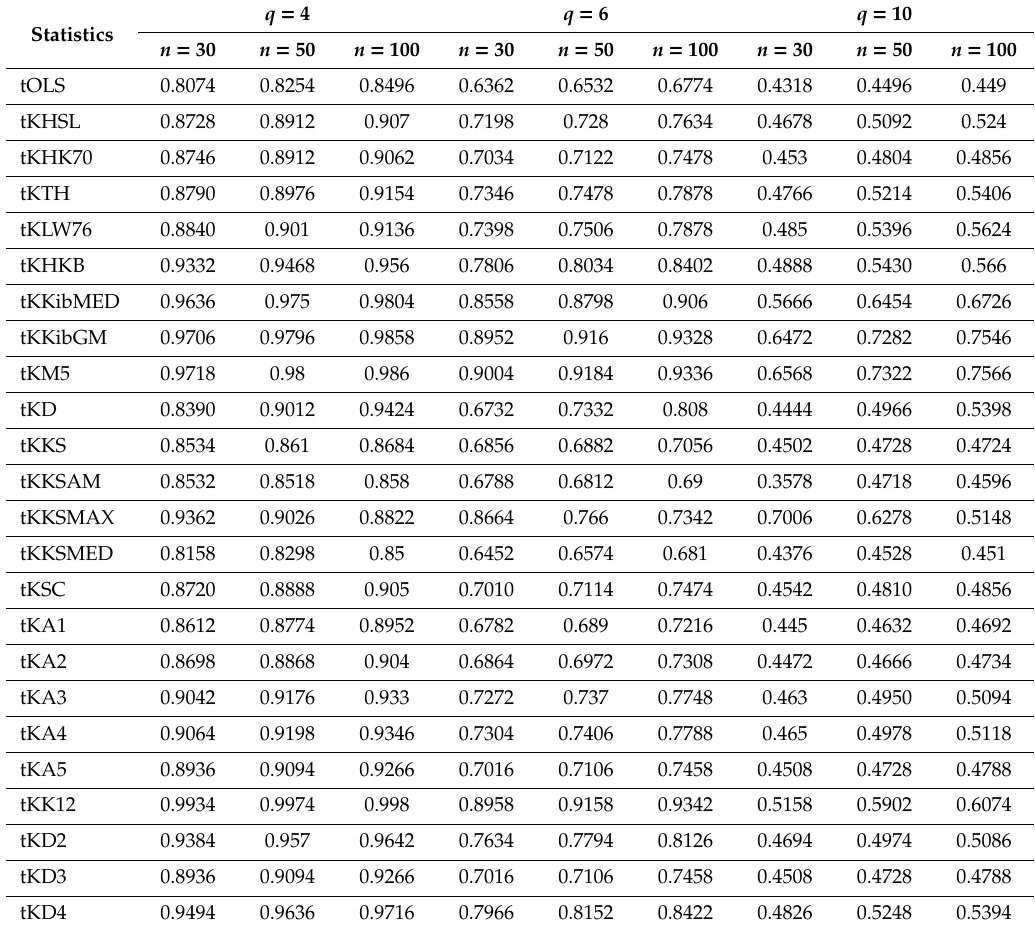
Table 5. Powers of tests for ρ = 0.80 and α =